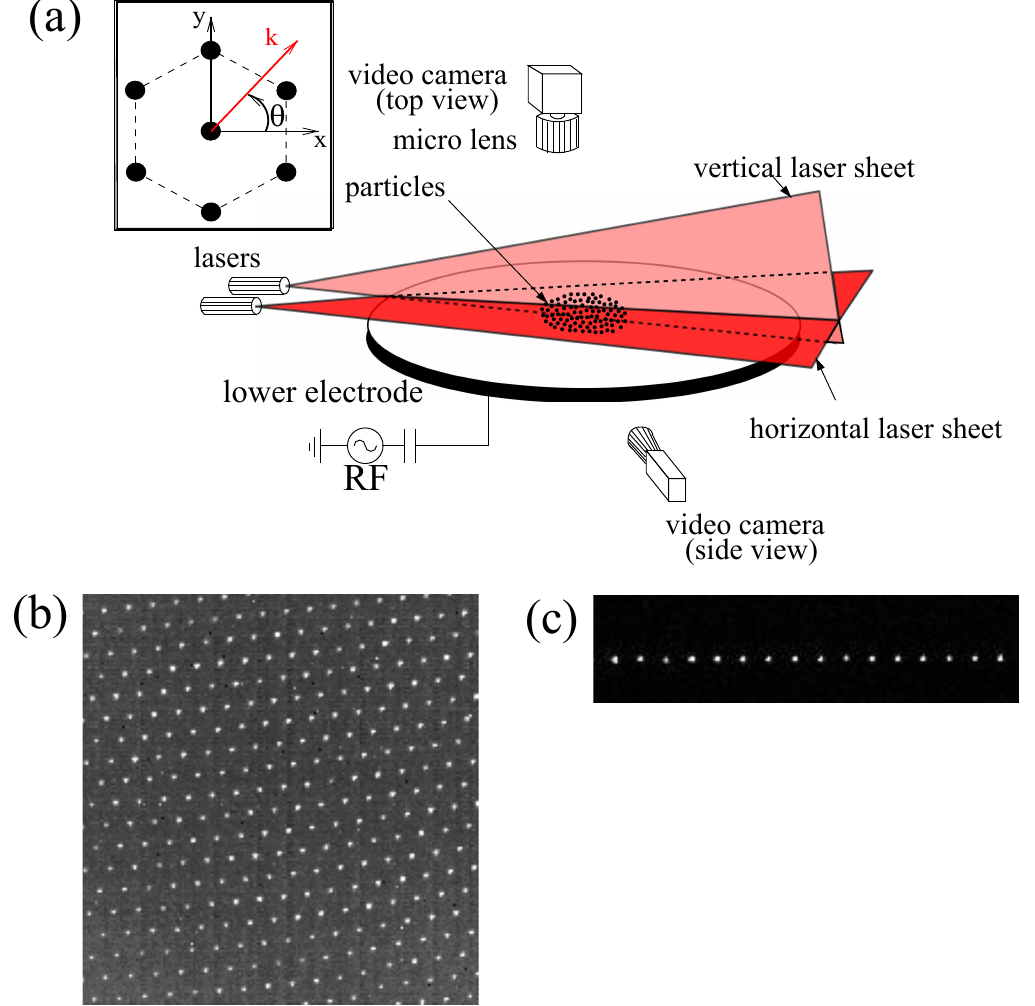
Figure 1. ( a ) Schematic diagram of the experimental setup. The inset shows the chosen orientation of the crystal lattice. ( b ) Top-view image of a 2D complex plasma crystal. ( c ) Side-view image of a 2D complex plasma crystal. Note that images ( b , c ) have been heavily reworked (nonlinear contrast and luminosity enhancements, Gaussian smoothing) and are therefore for illustration